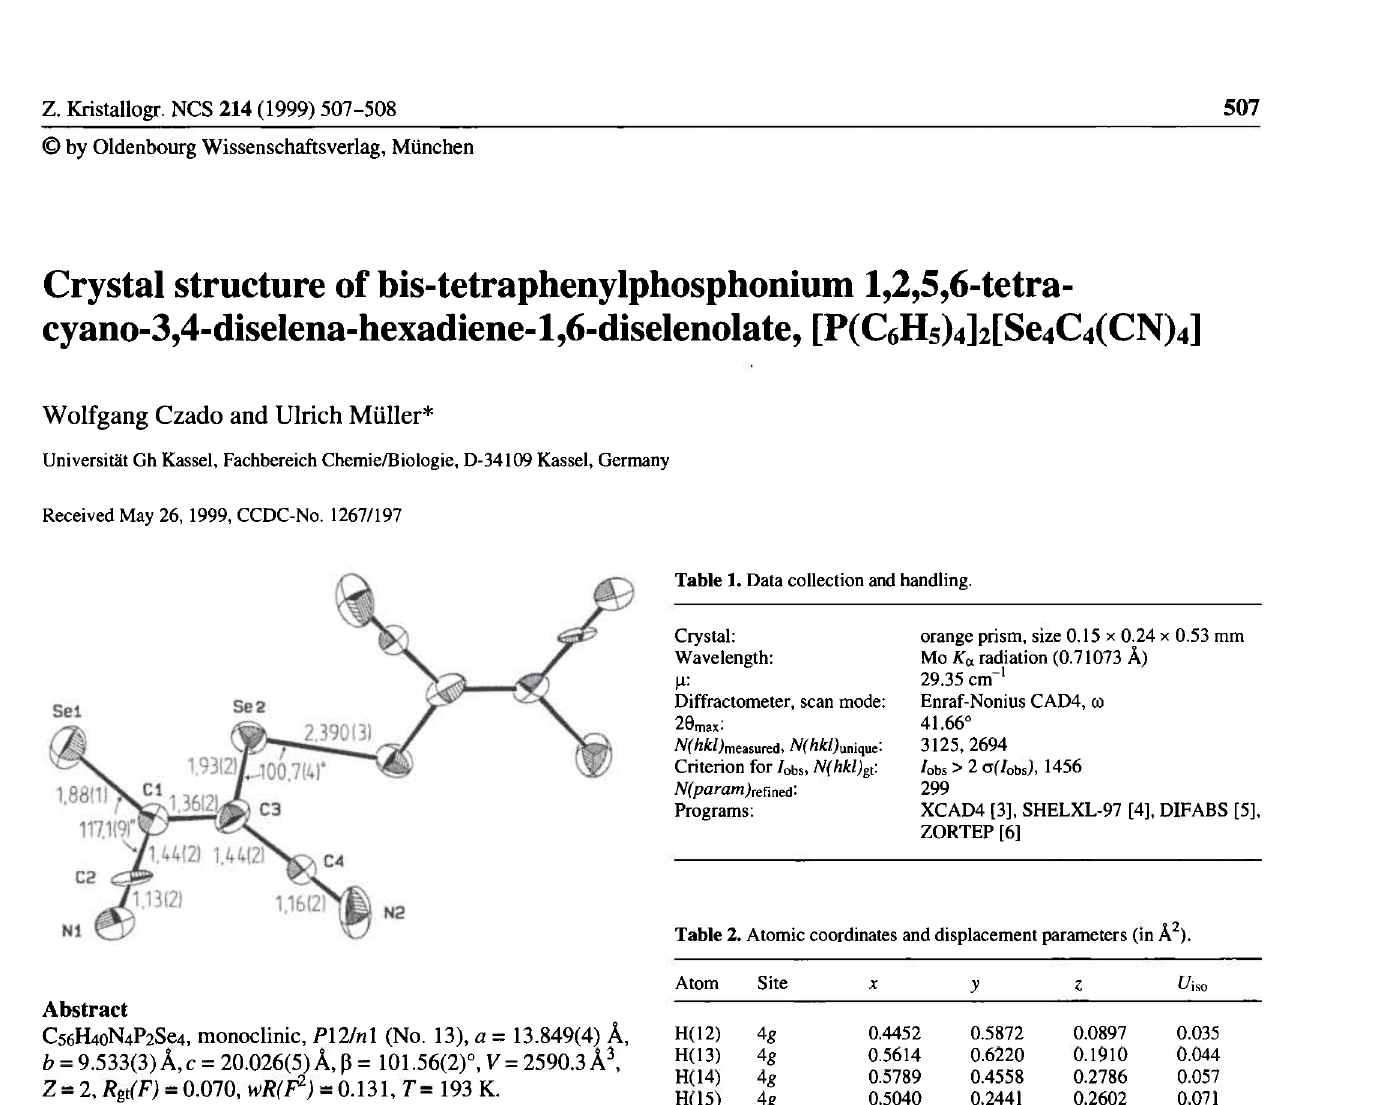
Table 2. Atomic coordinates and displacement parameters (in Ä 2